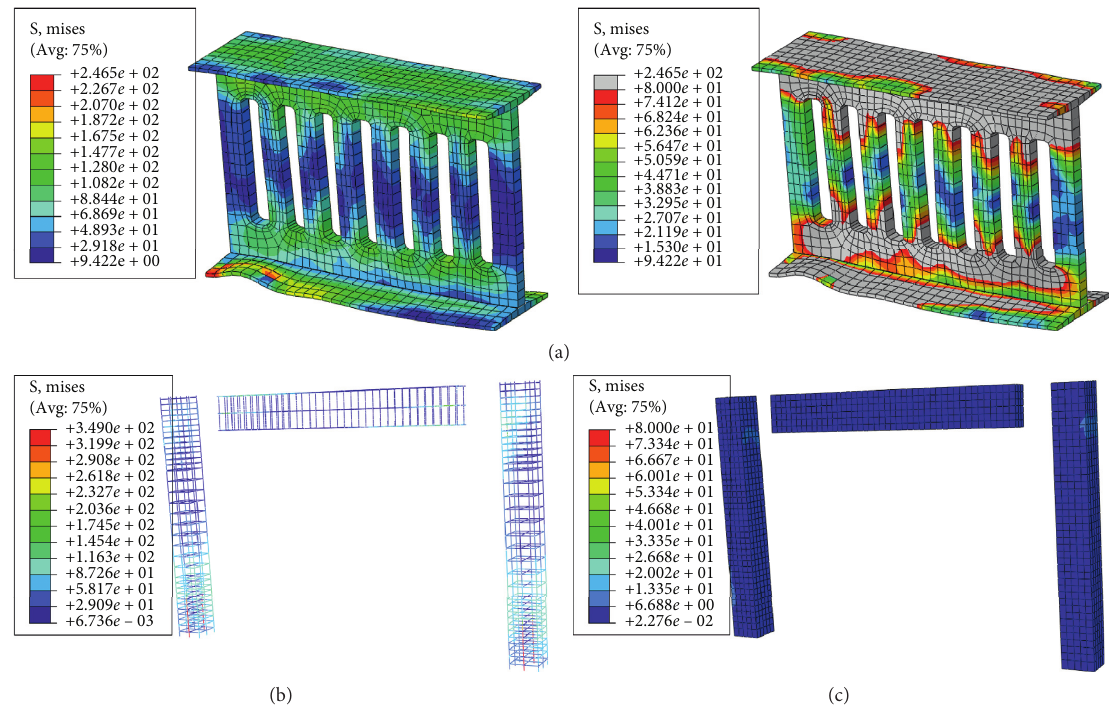
Figure 8: Stress nephograms of the damper, steel bar, and concrete at the horizontal drift of 60mm. (a) Stress nephogram of the damper. (b) Stress nephogram of the steel bar. (c) Stress nephogram of the